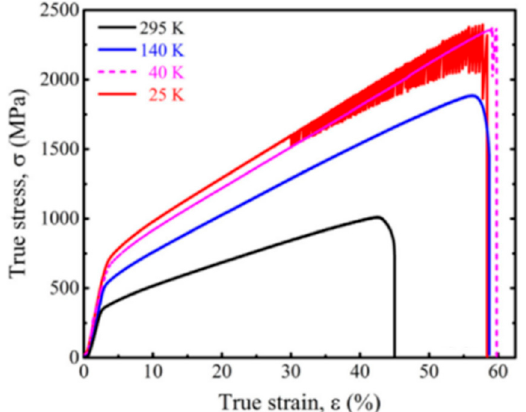
Figure 5. Stress–strain curves of the CrFeCoNi HEA at 295, 140, 40, and 25 K. Reprinted with per- mission from Ref. [27]. Copyright 2021, Elsevier.